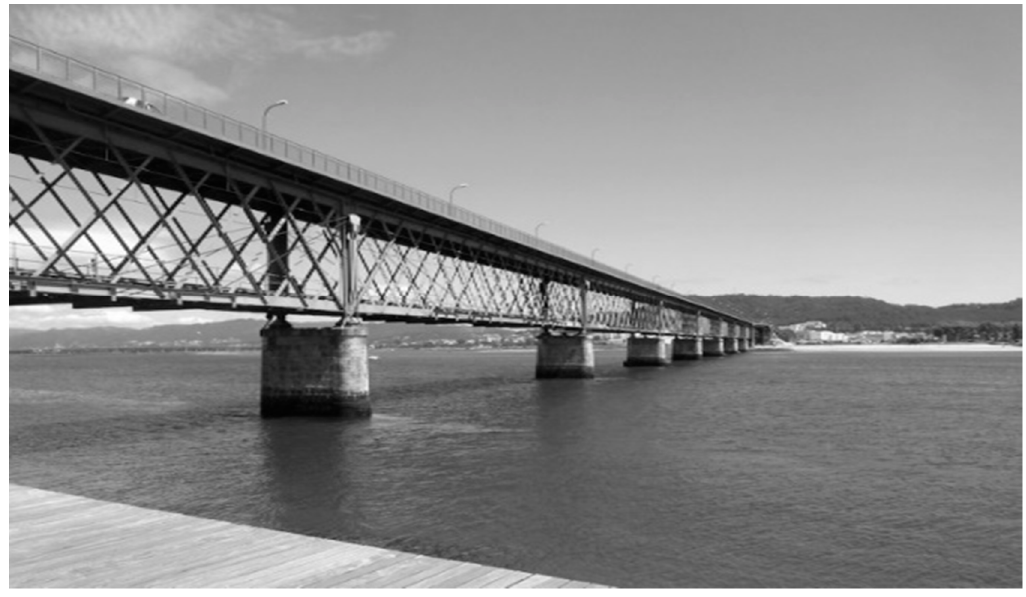
Figure 1. A view on the Eiffel Bridge.